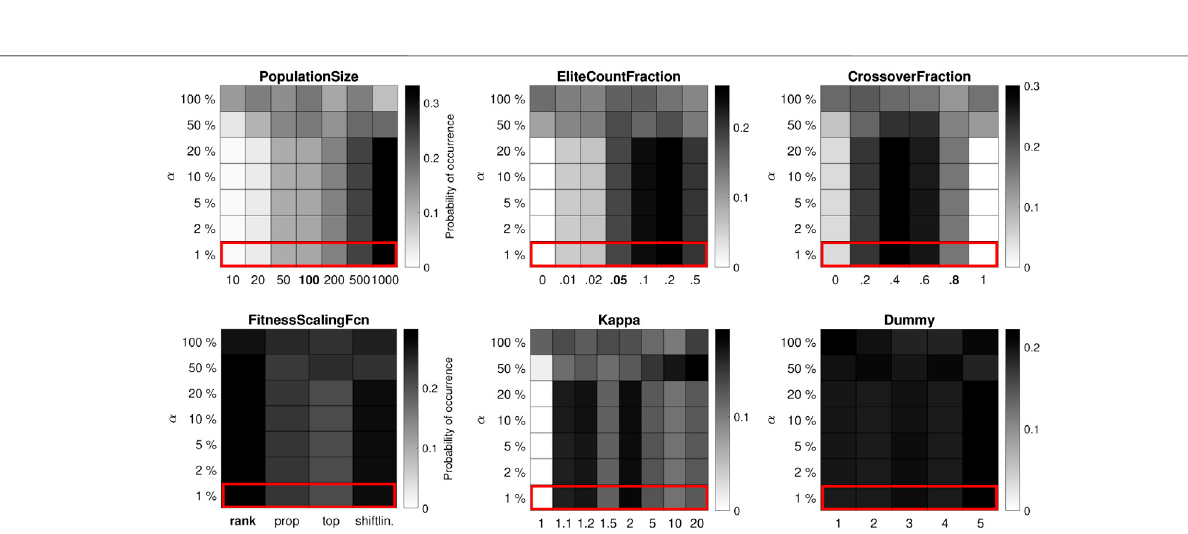
Frontiers in Built Environment |